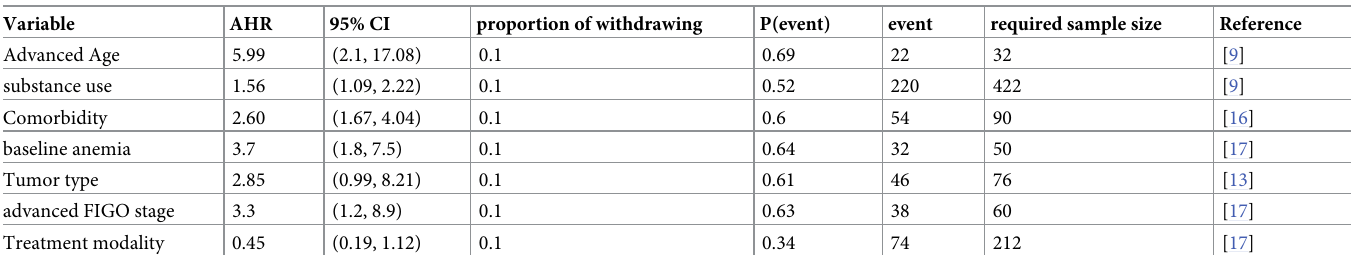
Table 1. Sample size to identify predictors of death among women with cervical cancer admitted at FHCSH, North West Ethiopia,